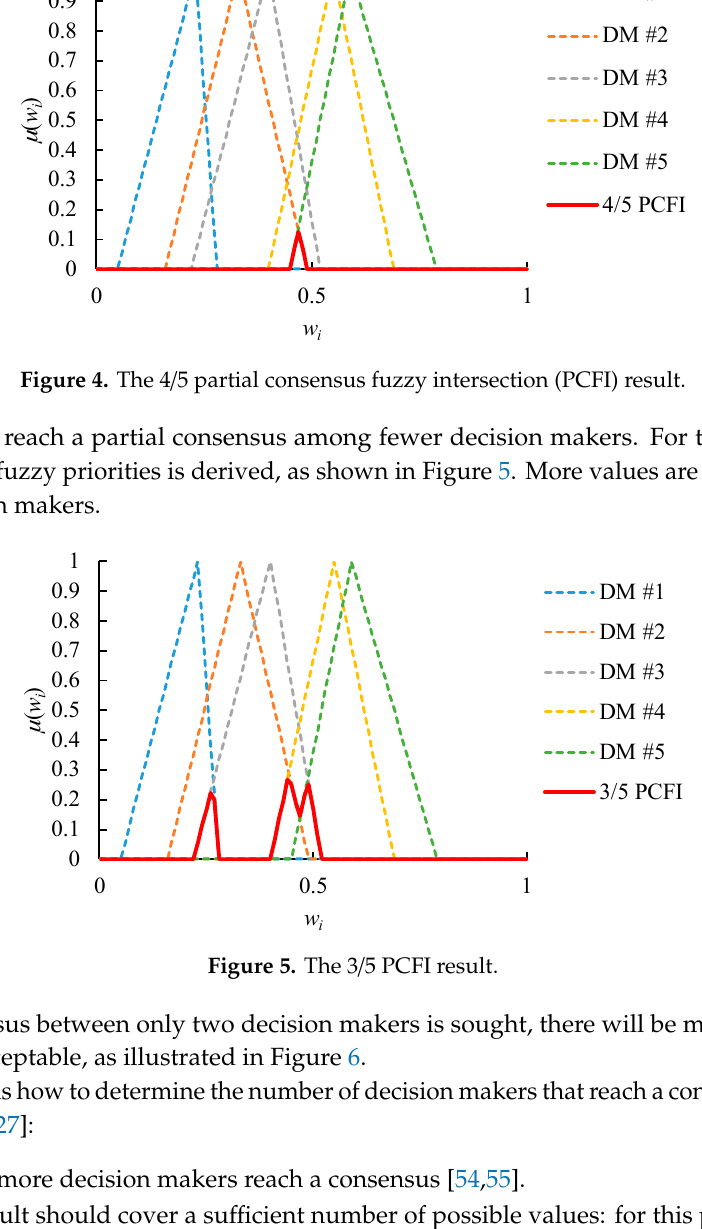
Figure 3. An example.